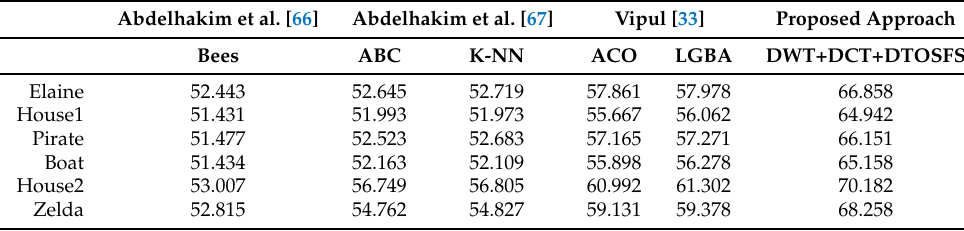
Table A1. Comparison of watermarking quality, measured using the